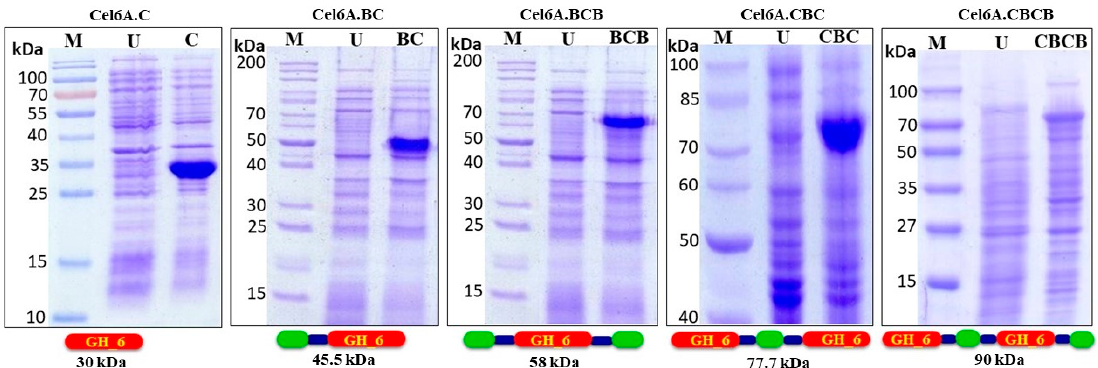
Figure 1. SDS-PAGE (12%) analysis of total E. coli BL-21 CodonPlus (RIPL) proteins expressing cel6A.C, cel6A.BC, cel6A.BCB, cel6A.CBC and cel6A.CBCB after induction with 0.4 mM IPTG. M : Protein Marker, U : Uninduced sample.